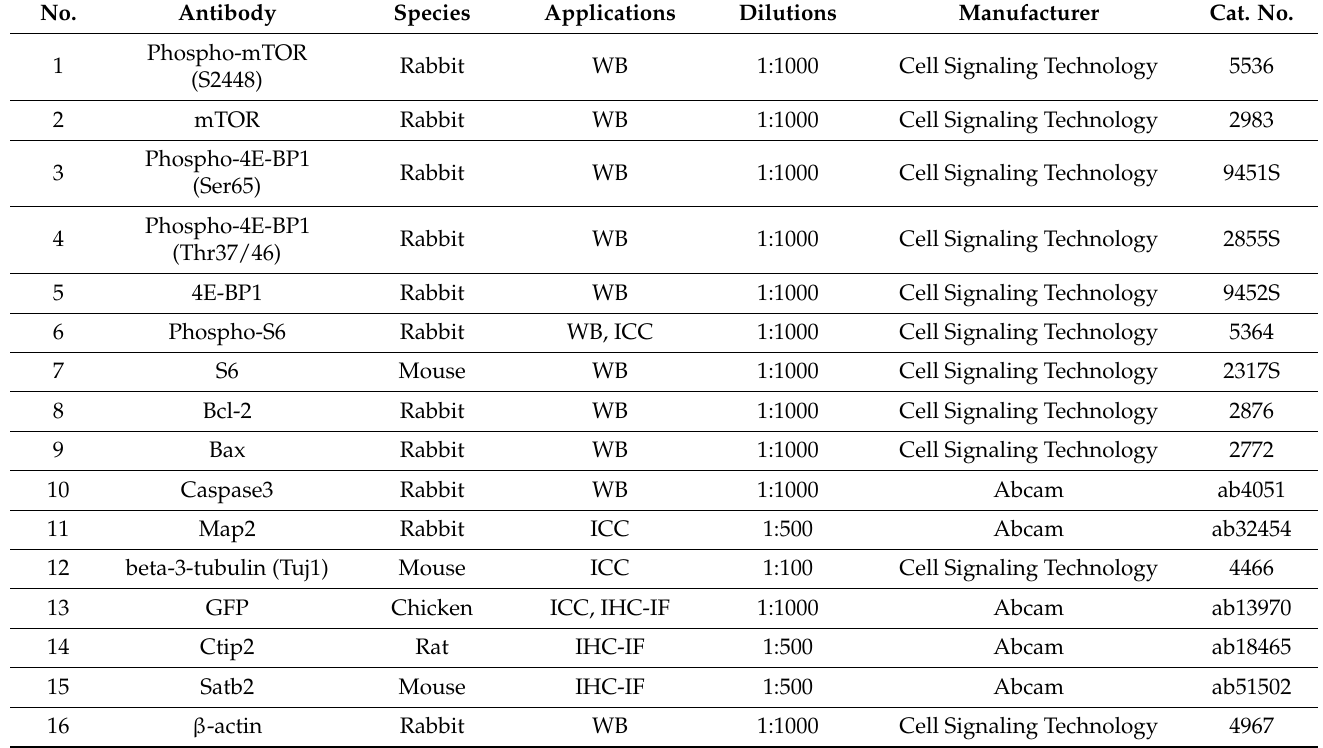
Table 1. List of antibodies used for Western blot (WB), immunocytochemistry (ICC), and immunohistochemistry (IHC). No. Antibody Species Applications